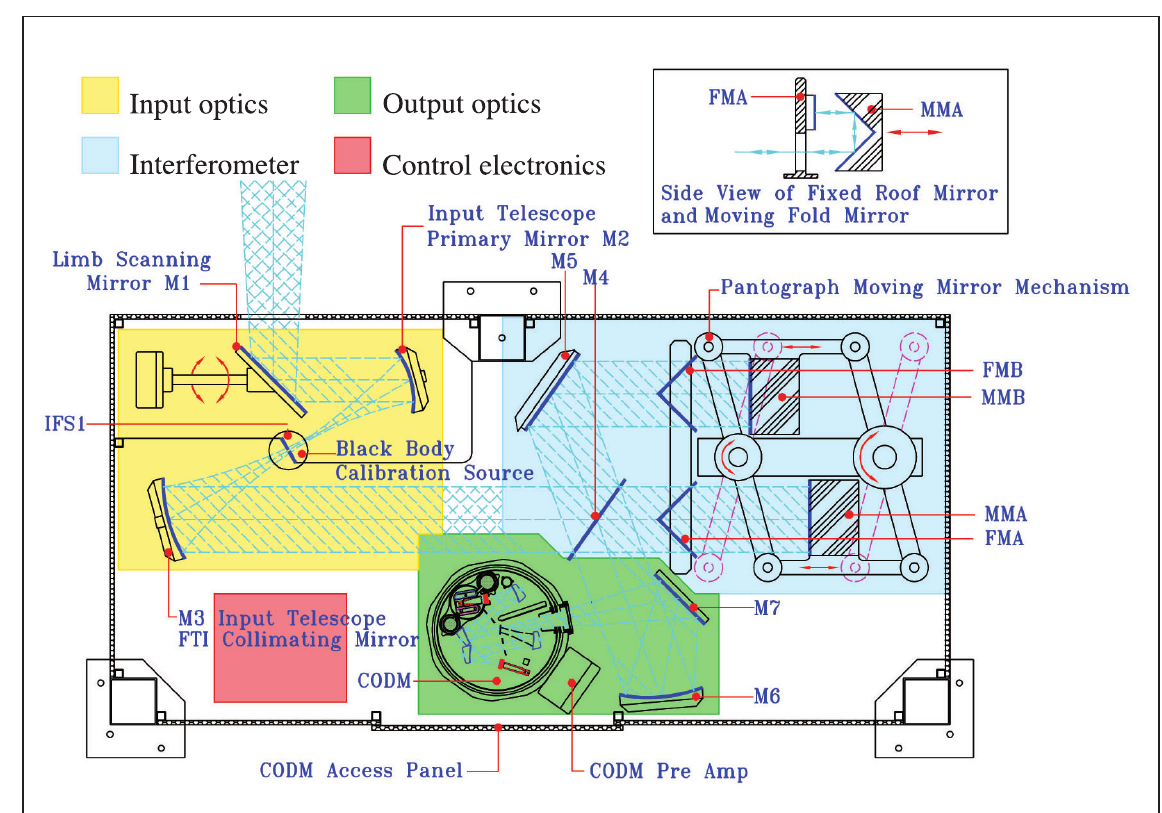
Fig. 5. The SAFIRE-A spectrometer, optical